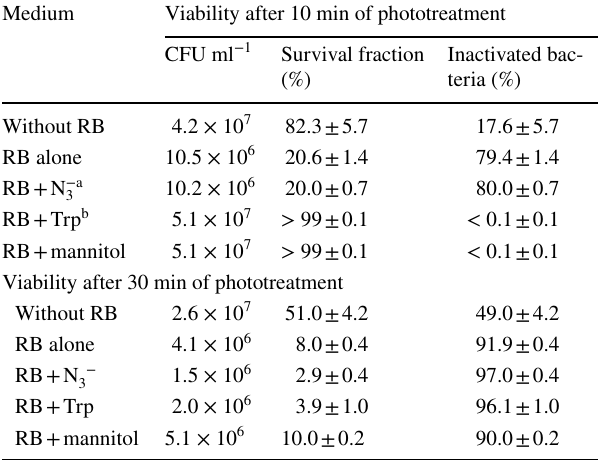
Table 2 Photoinactivation of S. aureus cultures in PBS (pH 7,3) treated with RB (20 µM) and artificial visible light (50 mW cm −2 ) in the presence of three antioxidants (10 mM) after 10 and 30 min of phototreatment at light fluence doses of 30 and 90 J cm −2 , respec-